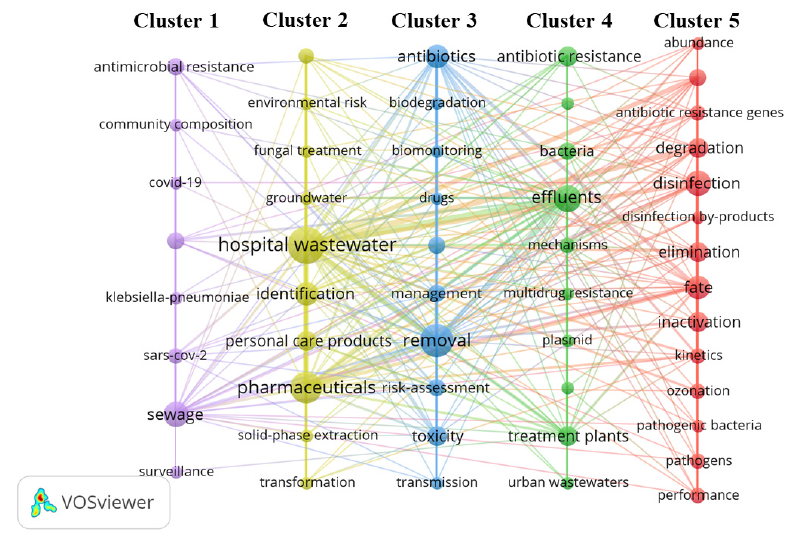
Figure 2. Keyword network clustering map for hospital wastewater treatment (The diameter of the circle is positively correlated with the frequency of keywords).